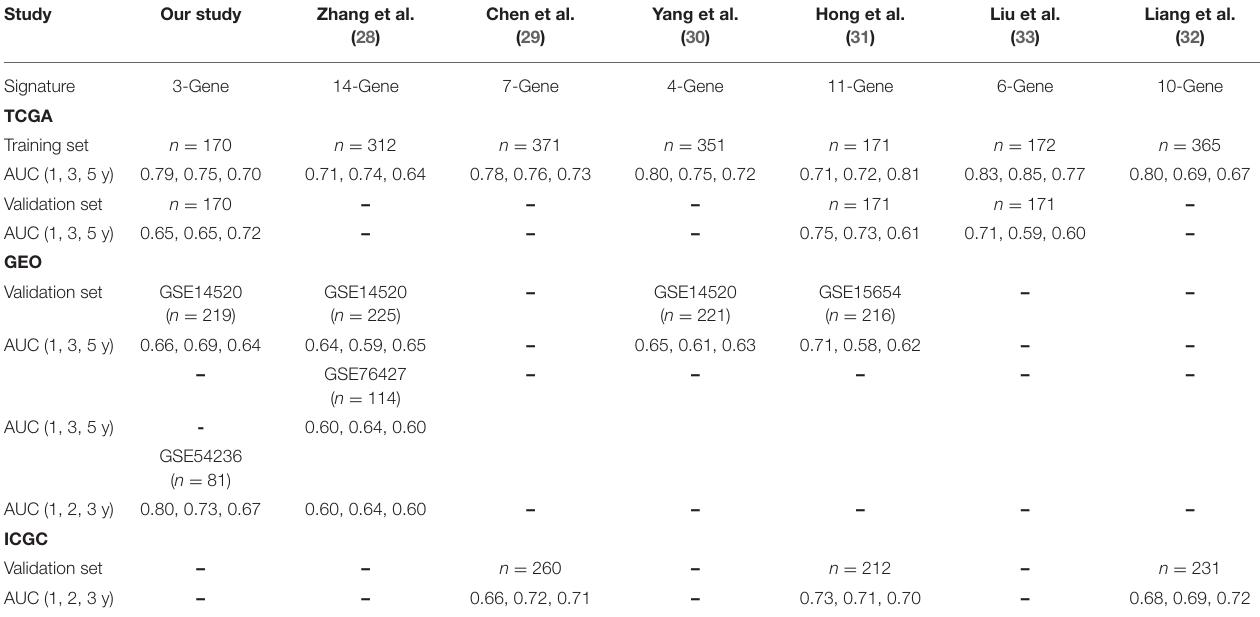
TABLE 2 | Comparison among HCC prognostic